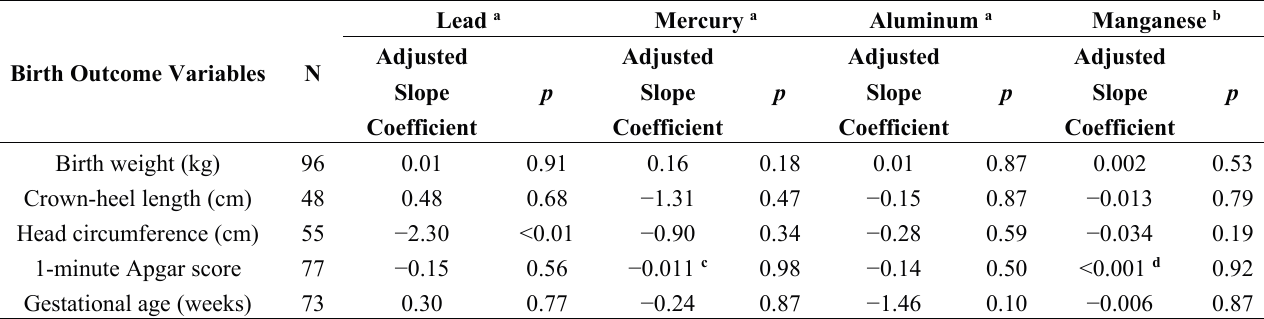
Table 6. Multivariable associations between cord blood metal concentrations and birth outcomes after controlling for SES and maternal education in the final multivariable linear regression models for birth